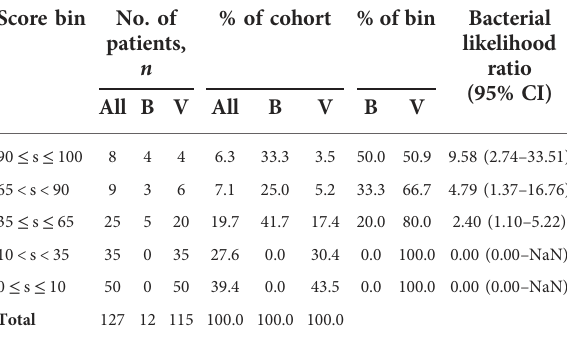
TABLE 2 Bv score